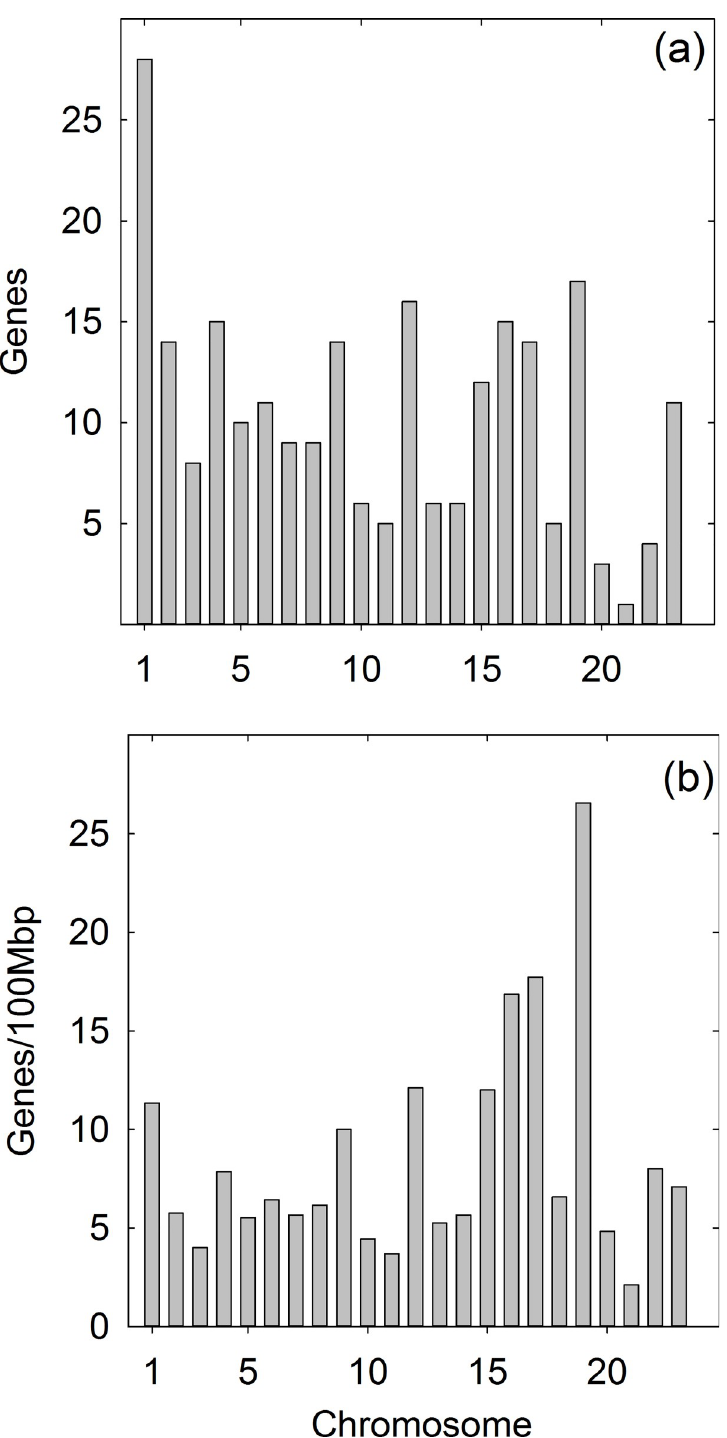
Fig 1. Chromosome distribution of database human testis-specific genes. (a) Number of database genes encoded on each chromosome. (b) Gene density expressed as database genes/100Mbp of chromosome sequence. Note the high density of database testis-specific genes on chromosome